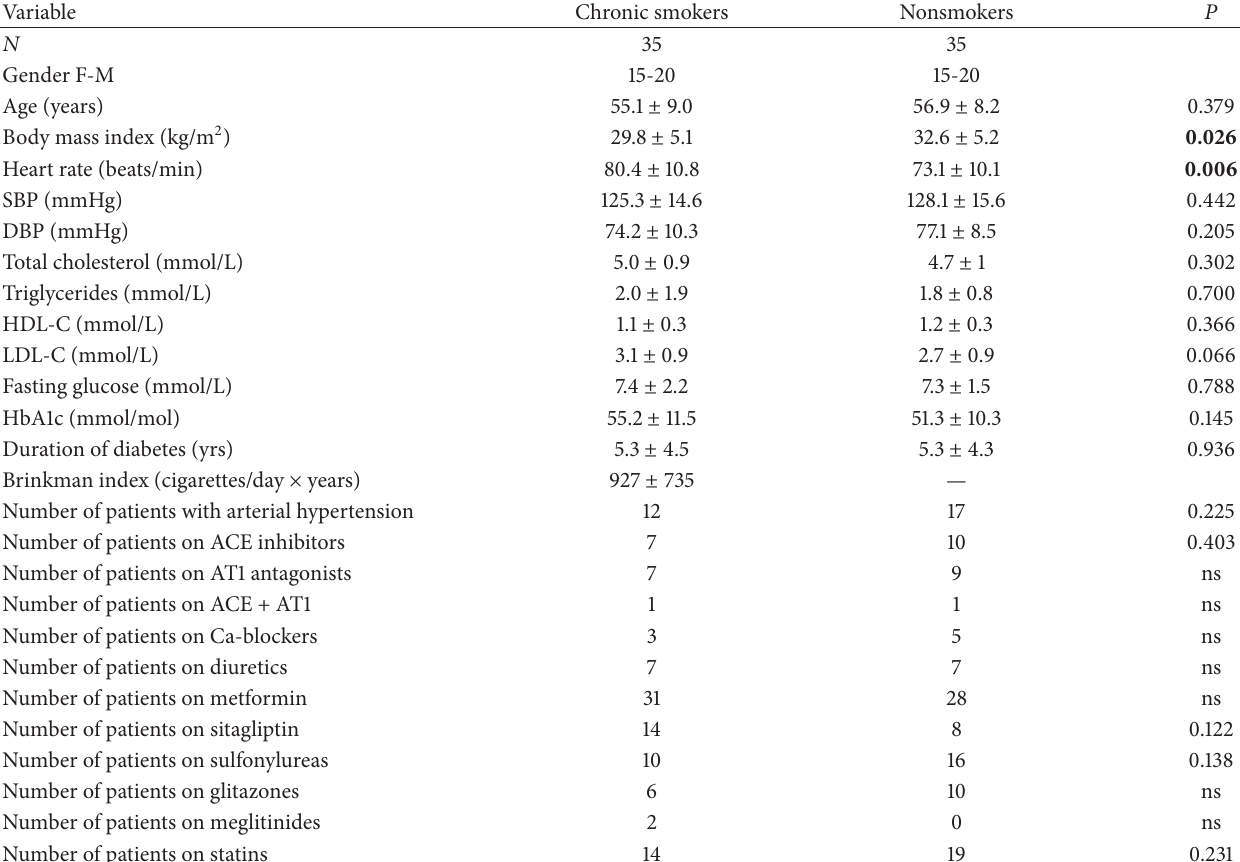
Table 1: Patients’ demographic and clinical characteristics (data are expressed as mean ±